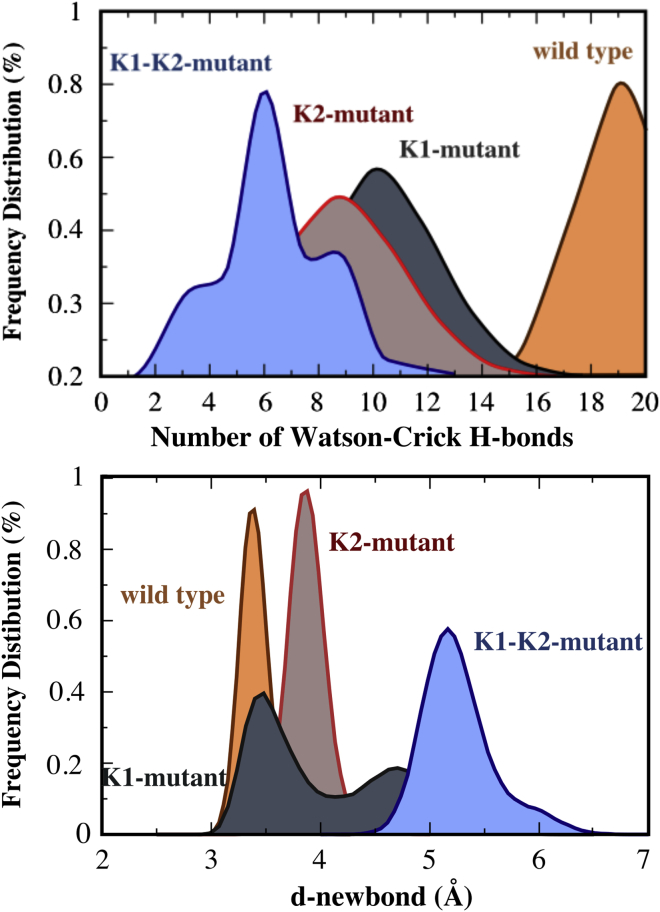
Molecular Dynamics Simulations of DNA Polymerase Pol-η Mutated at the K1- and K2-SitesTop: frequency distribution of the Watson-Crick inter-strand H-bonds in wild-type Pol-η, and in Pol-η mutated at the K1 site (K231A, K1-mutant), at the K2 site (K224A, K2-mutant), and at both K1 and K2 sites (K224A/K231A, K1-K2-mutant). Bottom: frequency distribution of the length d-newbond, defined in the main text (Genna et al., 2016a).